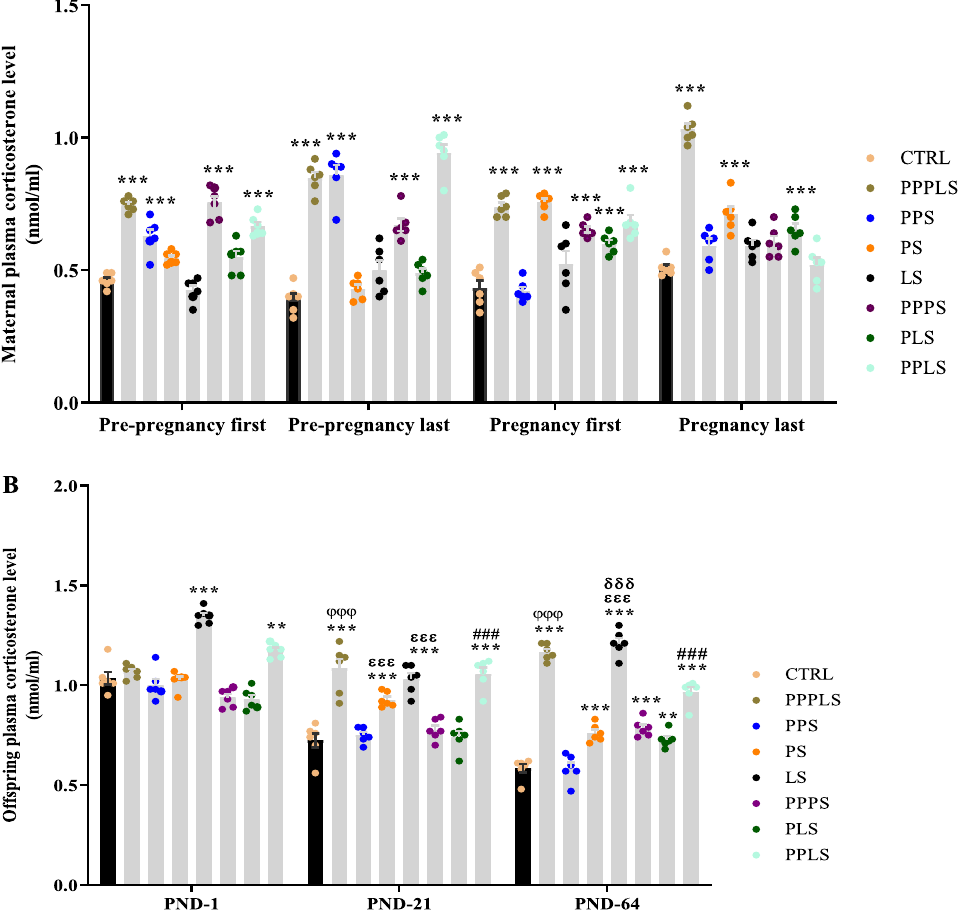
Figure 1. Effect of perinatal stress on corticosterone levels of maternal ( A ) and male offspring ( B ). Each column represents mean ± SEM (6 rats/group, 6 litters/group). Data was analyzed using two-way repeated measures ANOVA followed by Tukey’s post hoc test. The analysis were performed in each separate category; ** P < 0.01, *** P < 0.001 versus CTRL group; ### P < 0.001 versus PPS group; φφφ P < 0.001 versus PPPS group; ɛɛɛ P < 0.001 versus PLS group; δδδ P < 0.001 versus PPLS group. CTRL non stress, PPPLS pre-pregnancy, pregnancy, lactation stress, PPS pre-pregnancy stress, PS pregnancy stress, LS lactation stress, PPPS pre- pregnancy, pregnancy stress, PLS pregnancy, lactation stress, PPLS pre-pregnancy, lactation